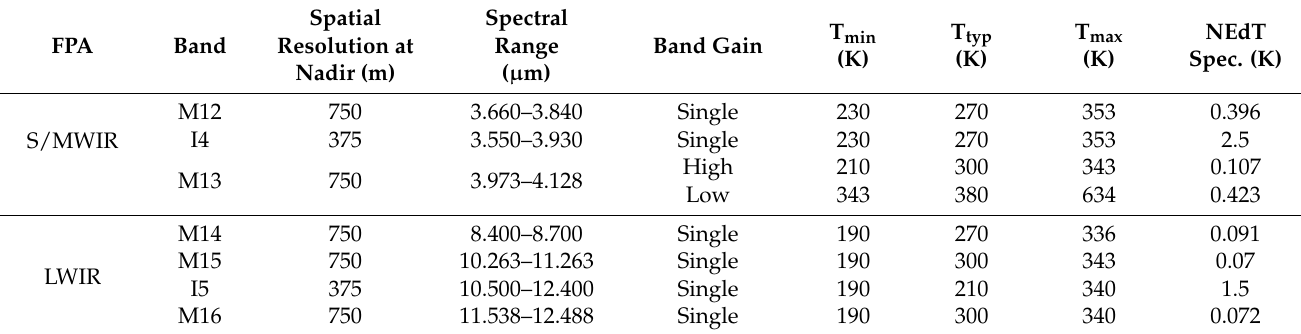
Table 1. VIIRS TEB design specifications including minimum (T min ), typical (T typ ), and maximum (T max ) scene temperatures. NEdT Spec. stands for NEdT specification at T typ .